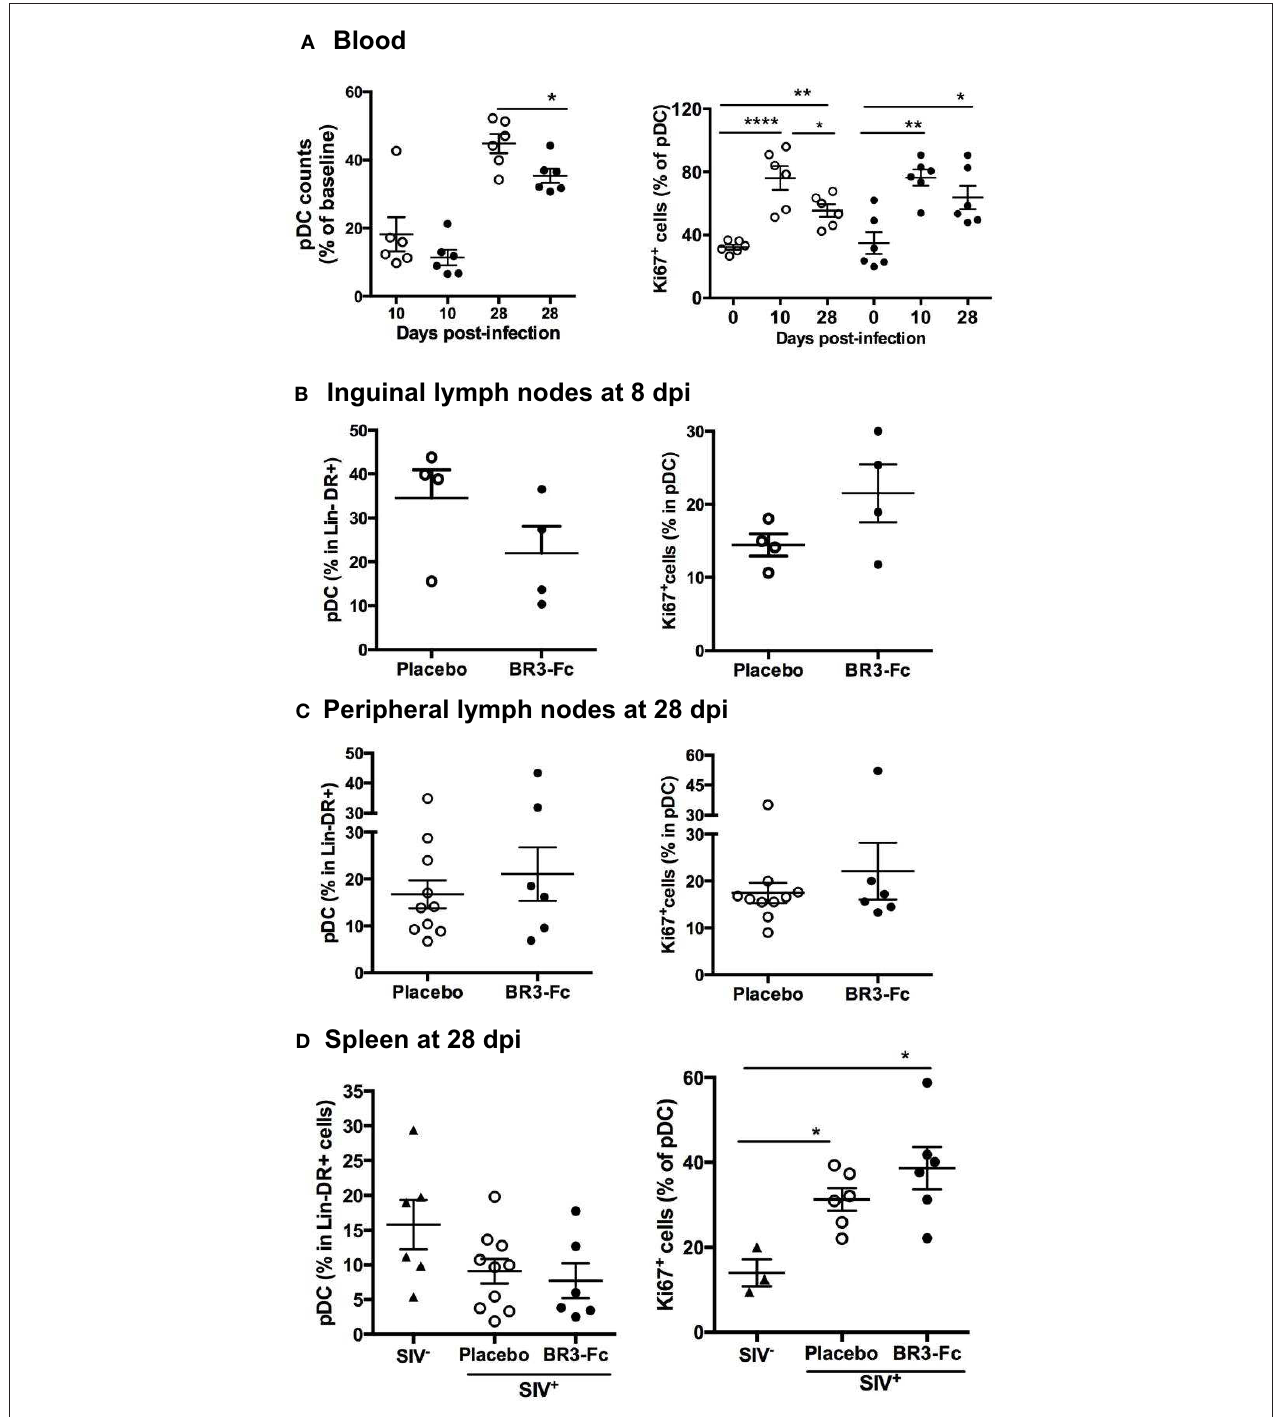
FIGURE 2 | Blockade of BAFF changes early pDC renewal in tissue. ( A , left panel) Change in blood pDC counts in Lin − DR + lymphocytes, expressed as the percentage of baseline value, was calculated as the ratio between the numbers of pDC at 10 or 28 dpi and that prior to infection (D0) for each animal. Statistics were carried out using the Mann Whitney non-parametric test, * p < 0.05. ( A , right panel) The percentage of pDC expressing Ki67 was determined prior to infection (D0), at 10 dpi (D10) and at 28 dpi (D28). For each group, statistics were carried out using the Wilcoxon matched-pairs signed rank test, * p < 0.05, ** p < 0.01, **** p < 0.0001. (B) Percentages of pDC in Lin − DR + cells (left panel) and of Ki67 + cells in pDC (right panel) were determined in cell suspensions from inguinal lymph nodes collected at 8 dpi from 4 Placebo and 4 Treated macaques. Similar quantifications were performed in cell suspensions from peripheral lymph nodes (C) or spleen (D) collected at 28 dpi from Placebo and Treated groups. Each dot represents one macaque of either Placebo ( open circle ) or Treated ( black circle ) group. Bars represent Mean values ± SEM. Statistics were carried out using the Mann Whitney non-parametric test, * p < 0.05.